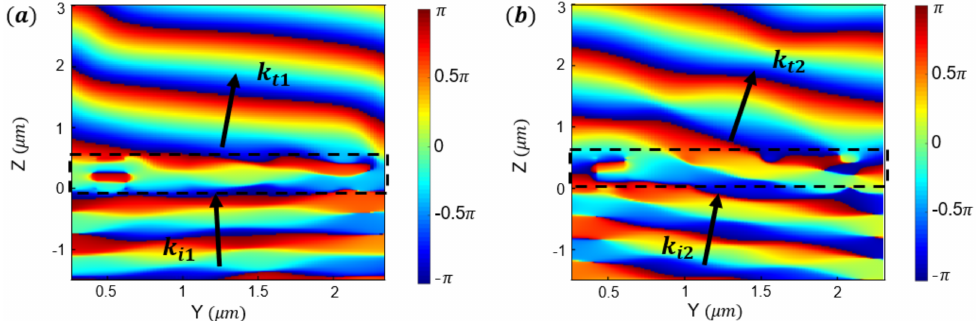
Figure 7. Simulation results of the metasurface combiner. ( a ) Phase profile of − 3.7 ◦ incident light enters from the substrate side of the metasurface. ( b ) Phase profile of 15 ◦ incident light enters from the substrate side of the metasurface.